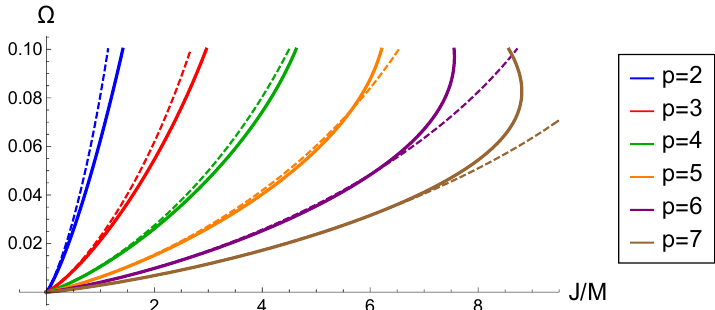
Figure 7 . The phase diagram of dumbbells. The approximation up to NLO in 1 / ∆ (dashed curves) is compared with the numerical result (solid curves). The numerical data is produced by the same method used in ref.